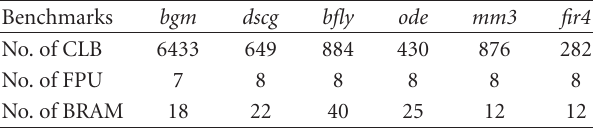
Table 2: Amount of FPU, CLB, and also BRAM used in each benchmark